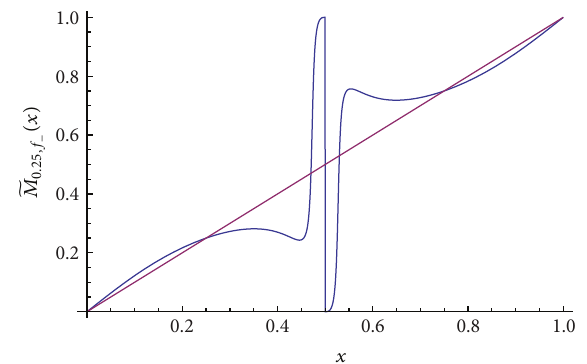
̃𝑀 𝜆 = 0.25 , where the BZ interval is 𝜆,𝑓 − with